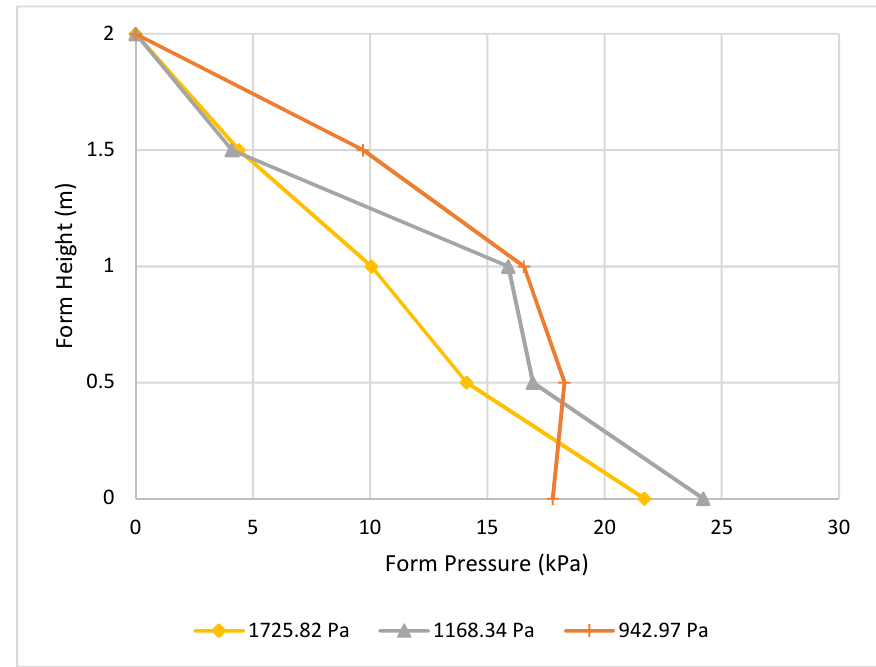
Figure 12. Effect of static yield stress at 15 min on form pressure.